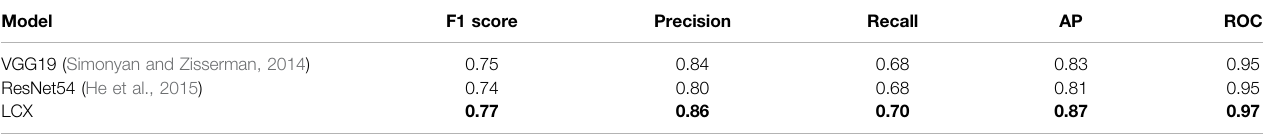
Bolded numbers indicate highest score obtained under each metric.